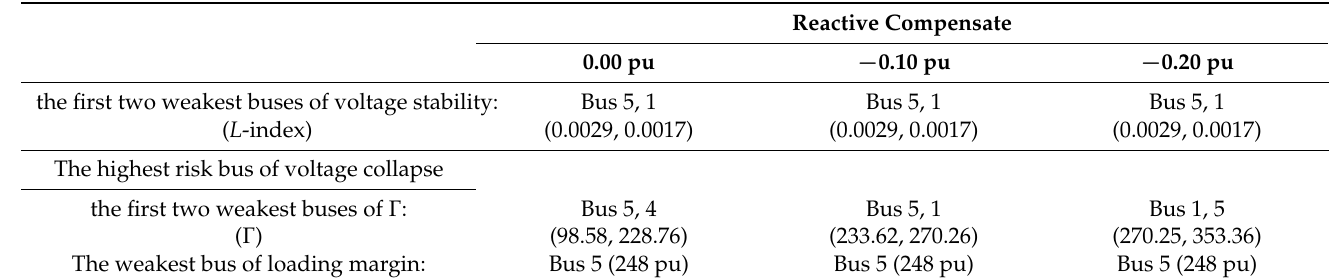
Table 2. Comparisons of first two weakest buses of voltage stability and the most vulnerable bus of voltage collapse on IEEE 5-bus distribution test system.